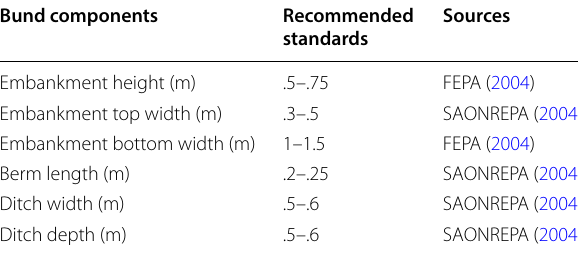
Table 1 Nationally recommended specifications of graded soil bunds for areas similar to Lemo